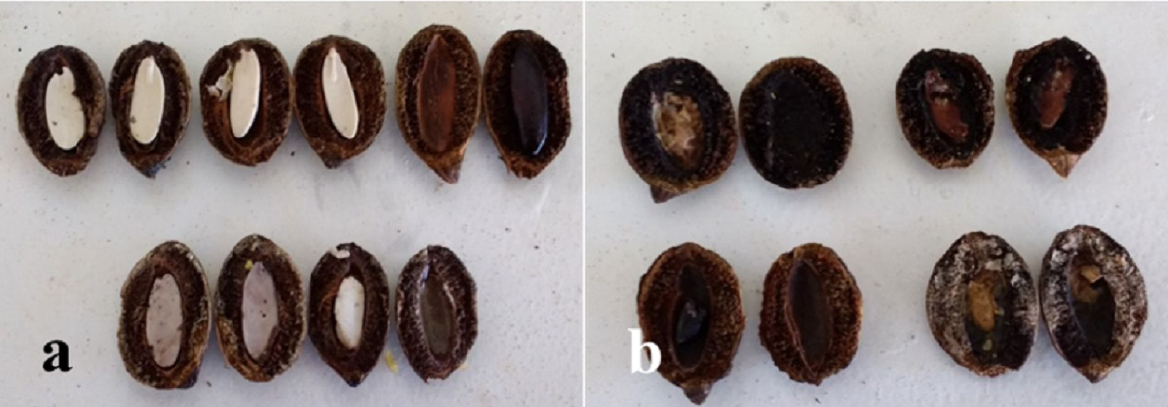
Figure 4. Open fruits with viable (a) and non-viable (b) seeds collected from the municipality of Corguinho, Mato Grosso do Sul,